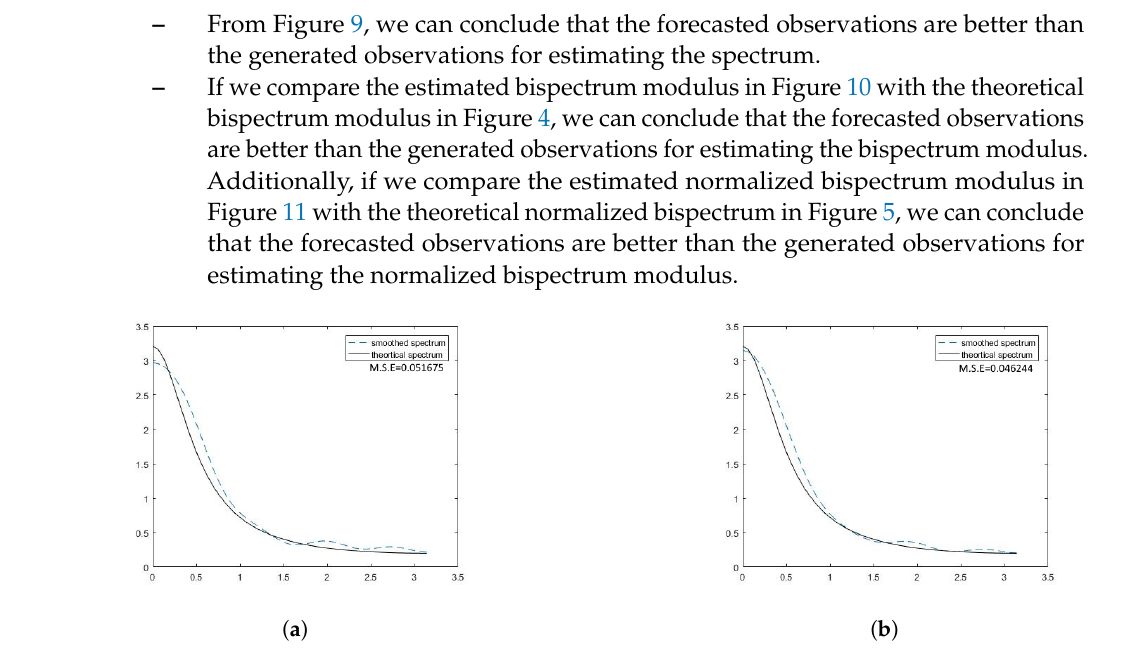
Figure 9. The estimated spectrum using the Parzen window and the theoretical spectrum. ( a ) Gener- ated observations. ( b ) Forecasted observations.